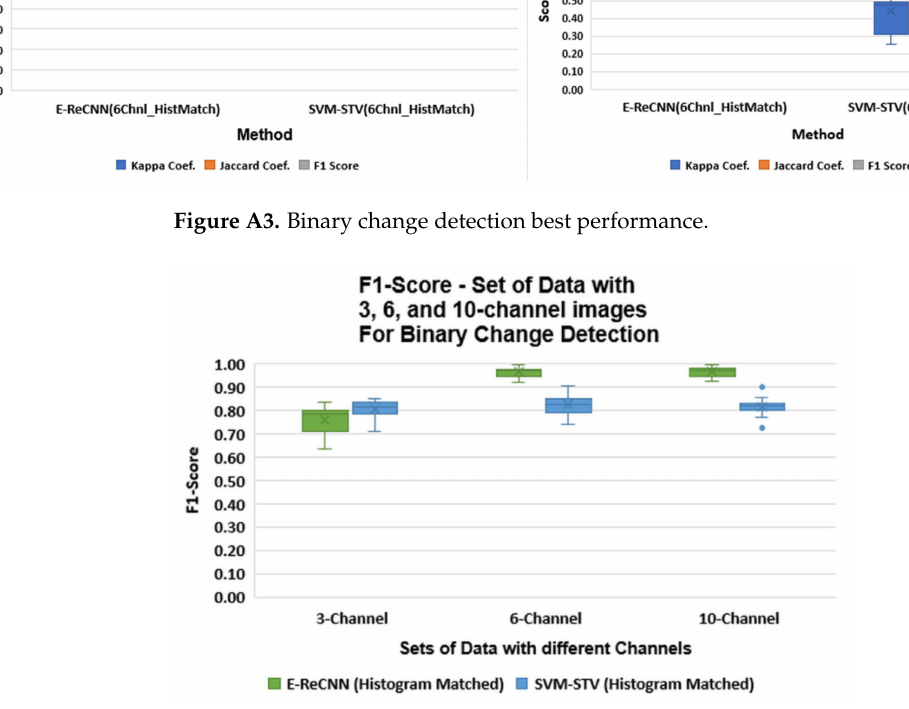
Figure A4. Binary Change Detection F1-Score for different